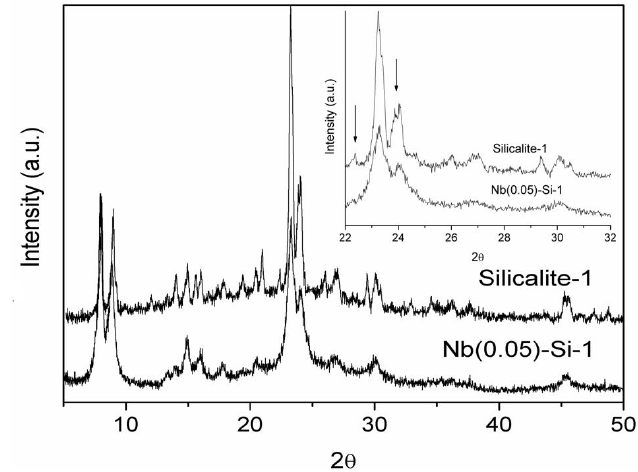
ff raction patterns of Silicalite-1 and Figure 3. X-ray powder diffraction patterns of Silicalite-1 and Nb(0.05)-Si-1. Figure 3. X-ray powder di Figure 3. X-ray powder diffraction patterns of Silicalite-1 and Nb(0.05)-Si-1.